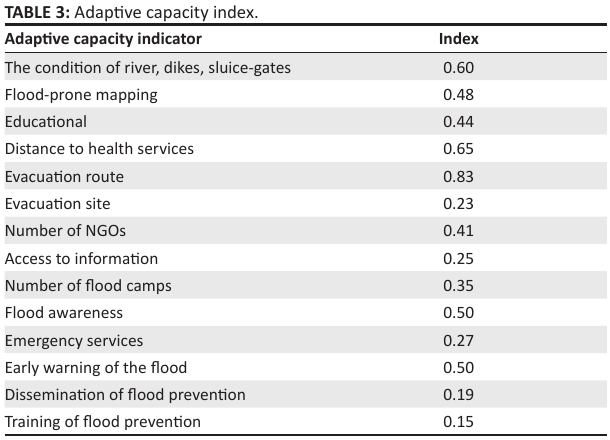
TABLE 3: Adaptive capacity index.